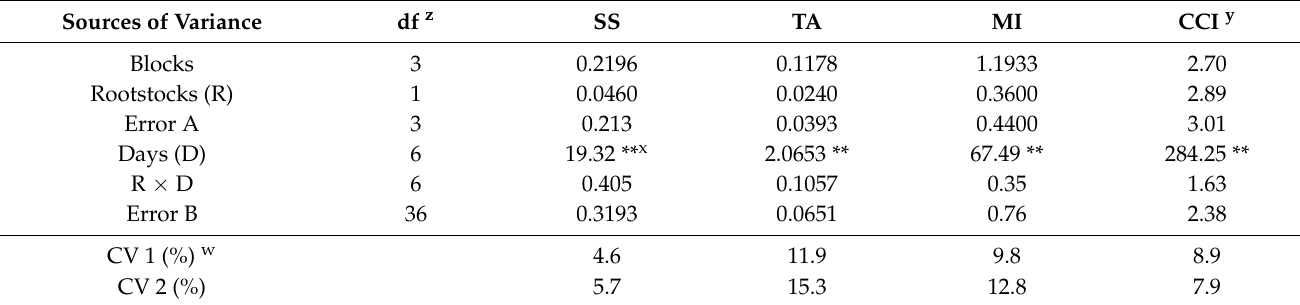
Table 5. Analysis of variance and mean squares of soluble solids (SS), titratable acidity (TA), maturation index (MI) or ratio (SS/TA), and citrus color index (CCI) over time of ‘Valencia’ orange fruits when trees are grafted on different ‘Trifoliata’ hybrid rootstocks at S ã o Jer ô nimo da